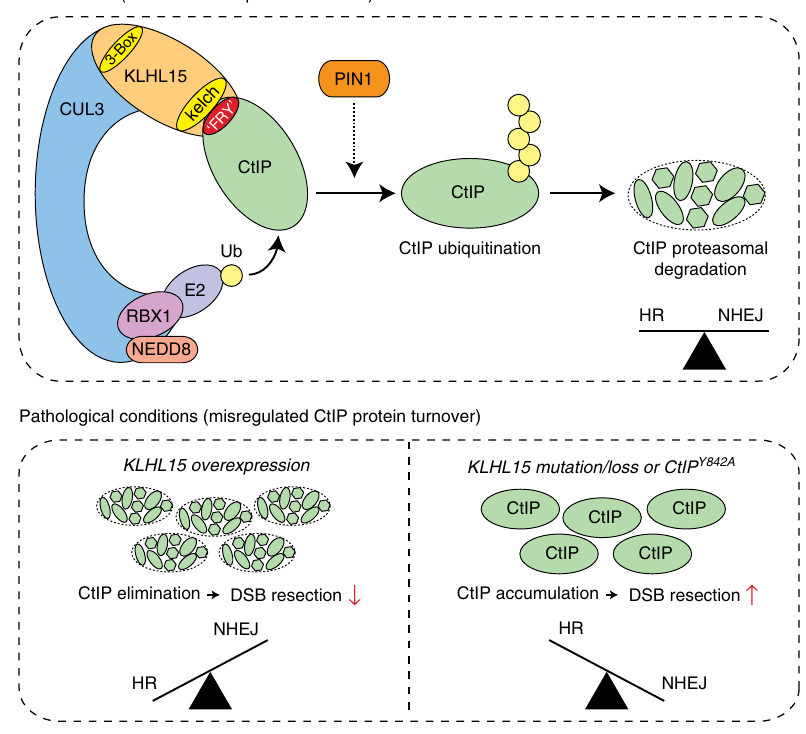
Figure 9 | CtIP ubiquitination by CUL3-KLHL15 promotes CtIP proteasomal degradation to fine-tune DNA-end resection and DSB repair pathway choice. Schematic model depicting the molecular architecture of the CUL3-KLHL15 E3 ubiquitin ligase complex and the functional consequences of KLHL15-mediated CtIP protein turnover in controlling the balance between NHEJ and HR in normal KLHL15-expressing cells (upper part) and under pathological conditions of altered KLHL15 expression (lower part). CtIP isomerization by PIN1 triggers CtIP proteasomal degradation 28 at least in part by facilitating CtIP ubiquitination by the CUL3-KLHL15 E3 ligase complex. See discussion for more